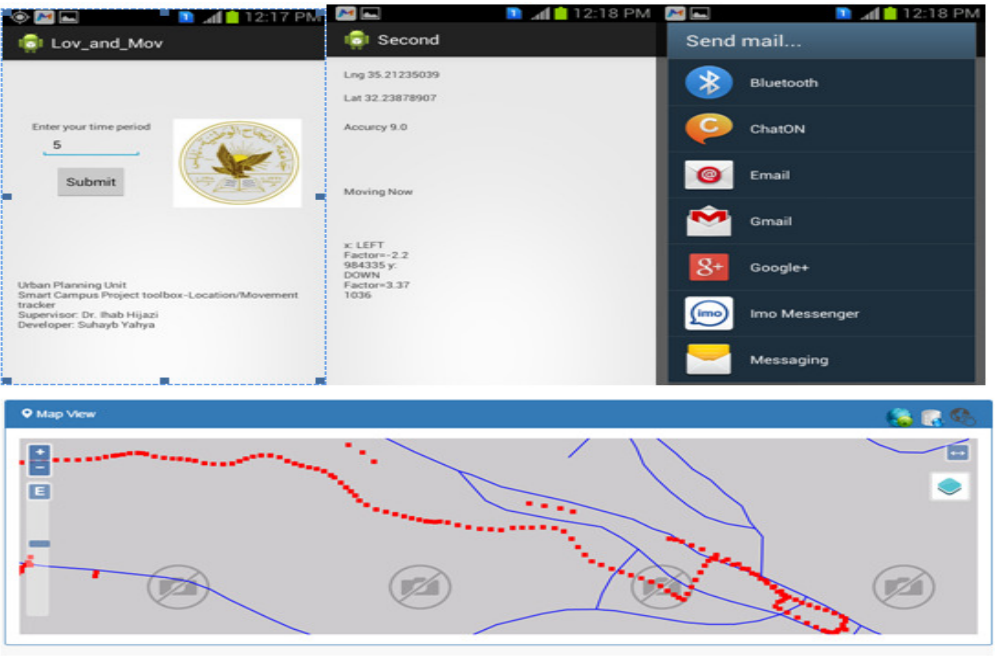
Figure 1. Mobile App interfaces and Data